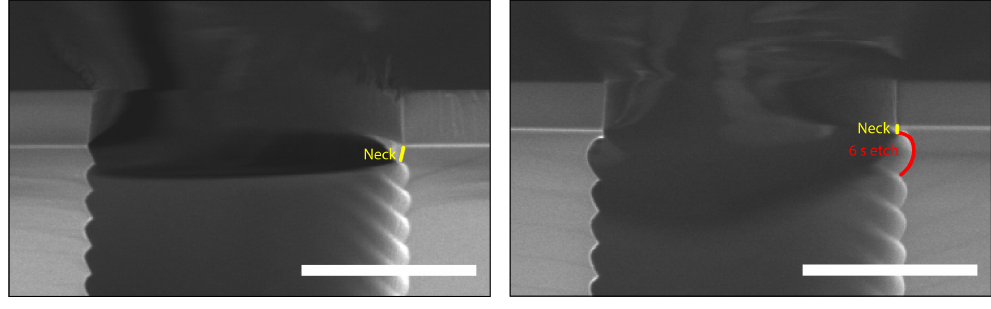
Figure 10. SEM images of the trench entrance etched with a 6s isotropic entrance etch step. ( a ) No stripping of FC was performed after the RIE of the t-SiO 2 hard mask. It was expected that the remaining FC from this recipe would prevent the widening of the entrance. ( b ) Stripping of FC was performed prior to the HAR etch. Here, a widened first scallop is visible. However, the neck above this scallop is smaller but still present. The scale bars in ( a , b ) are 1µm.